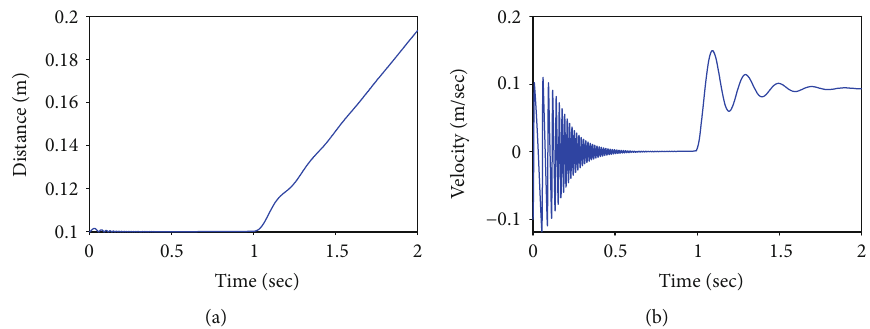
Figure 4: Dynamic response of two contact objects ( stiffness = 1 × 10 5 , damping = 100 ): (a) relative distance of S of S and S . 1 2